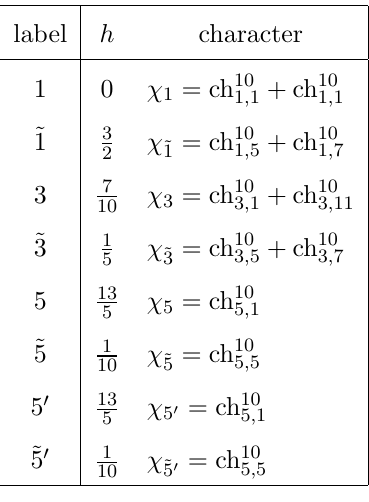
Table 7 . The NS representations of SW (10) at c = 7 =